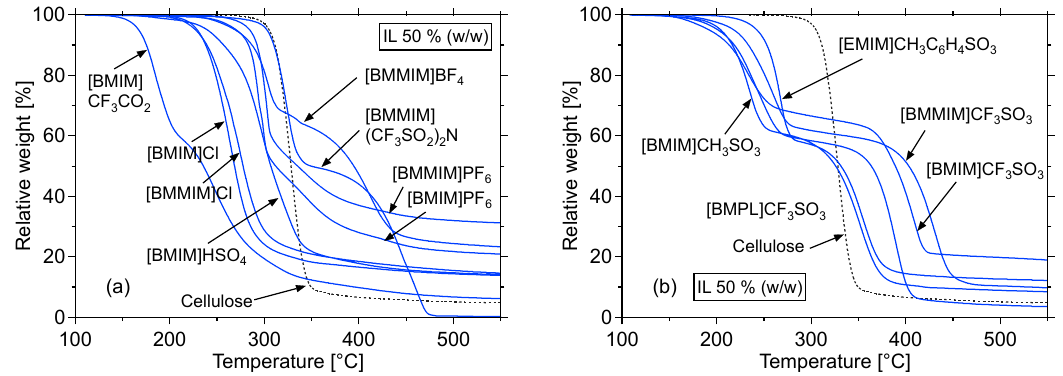
Figure 3. Weight loss curves of cellulose and cellulose/IL mixtures; TGA under flowing nitrogen with 5 °C/min heating